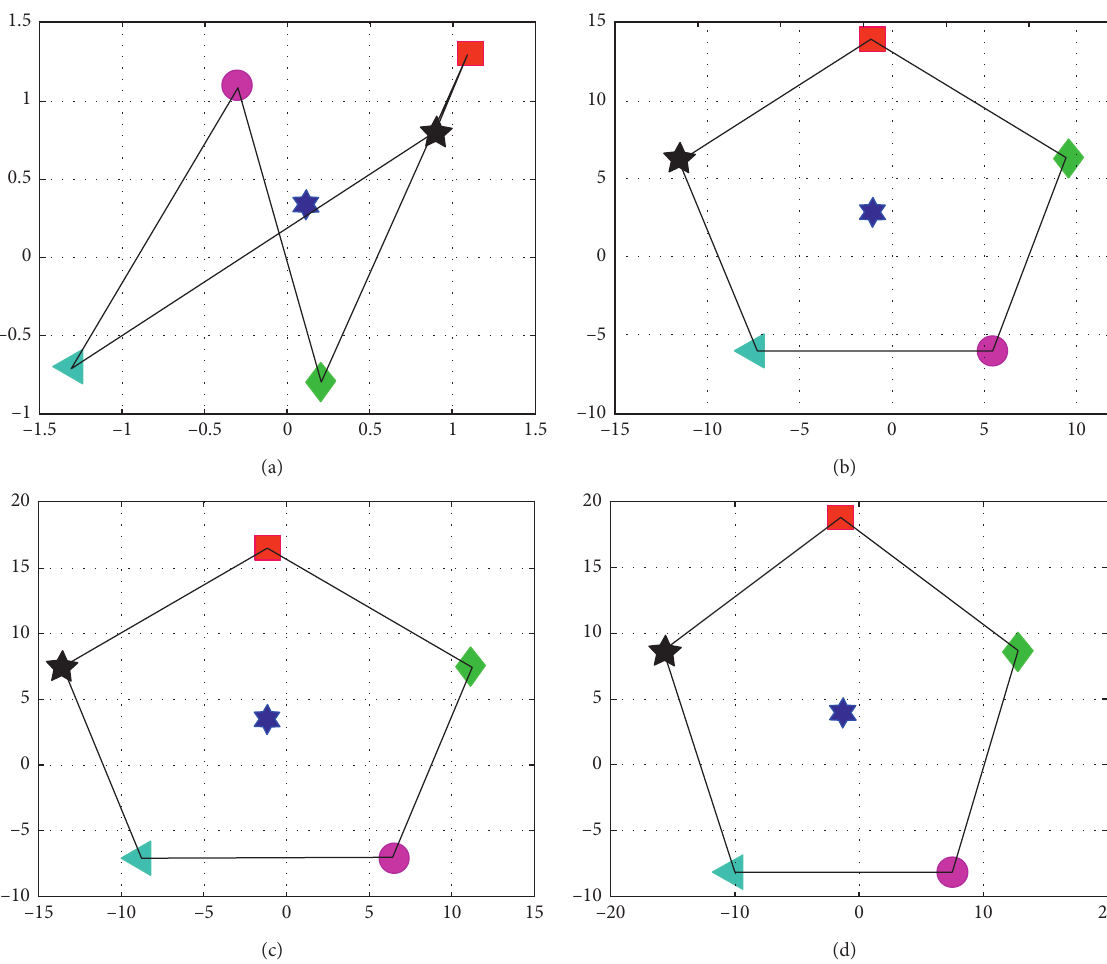
Figure 4: State snapshots of five agents at different times for the leaderless case. (a) t � 0s . (b) t � 12s . (c) t � 14s . (d) t � 15s .